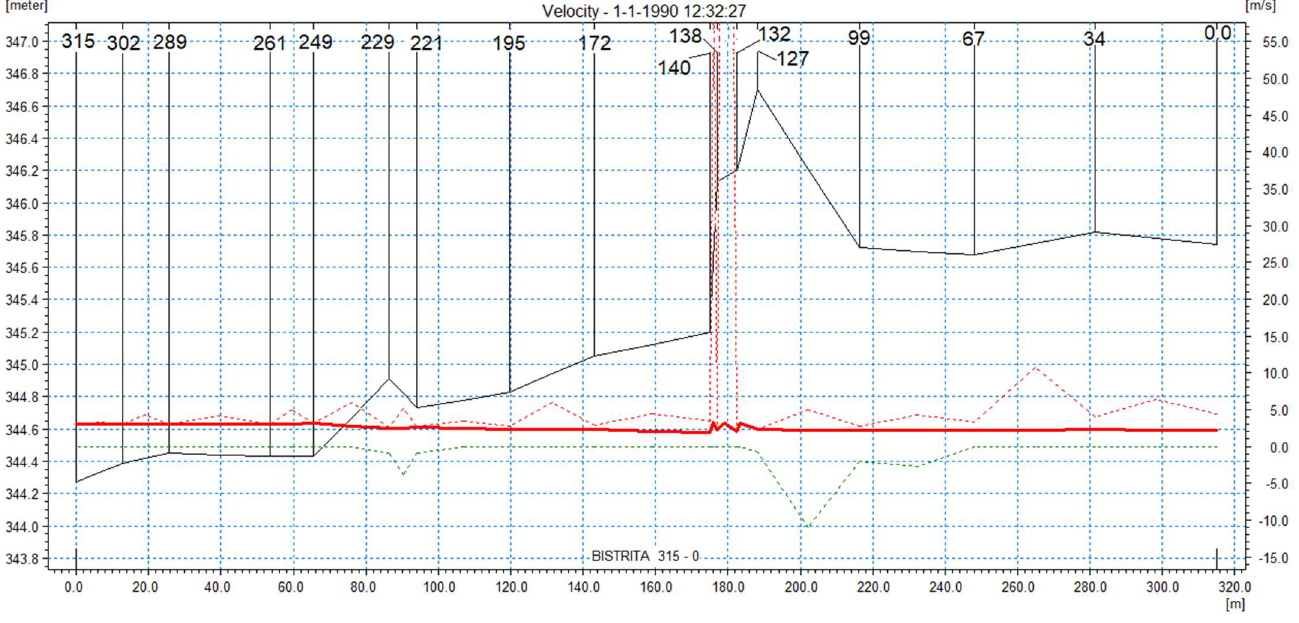
Figure 11. Water speed for flow Q = 128 m 3 /s, representing an extreme flood flow recorded in 2020. For the case where there is only one weir, the existing one.